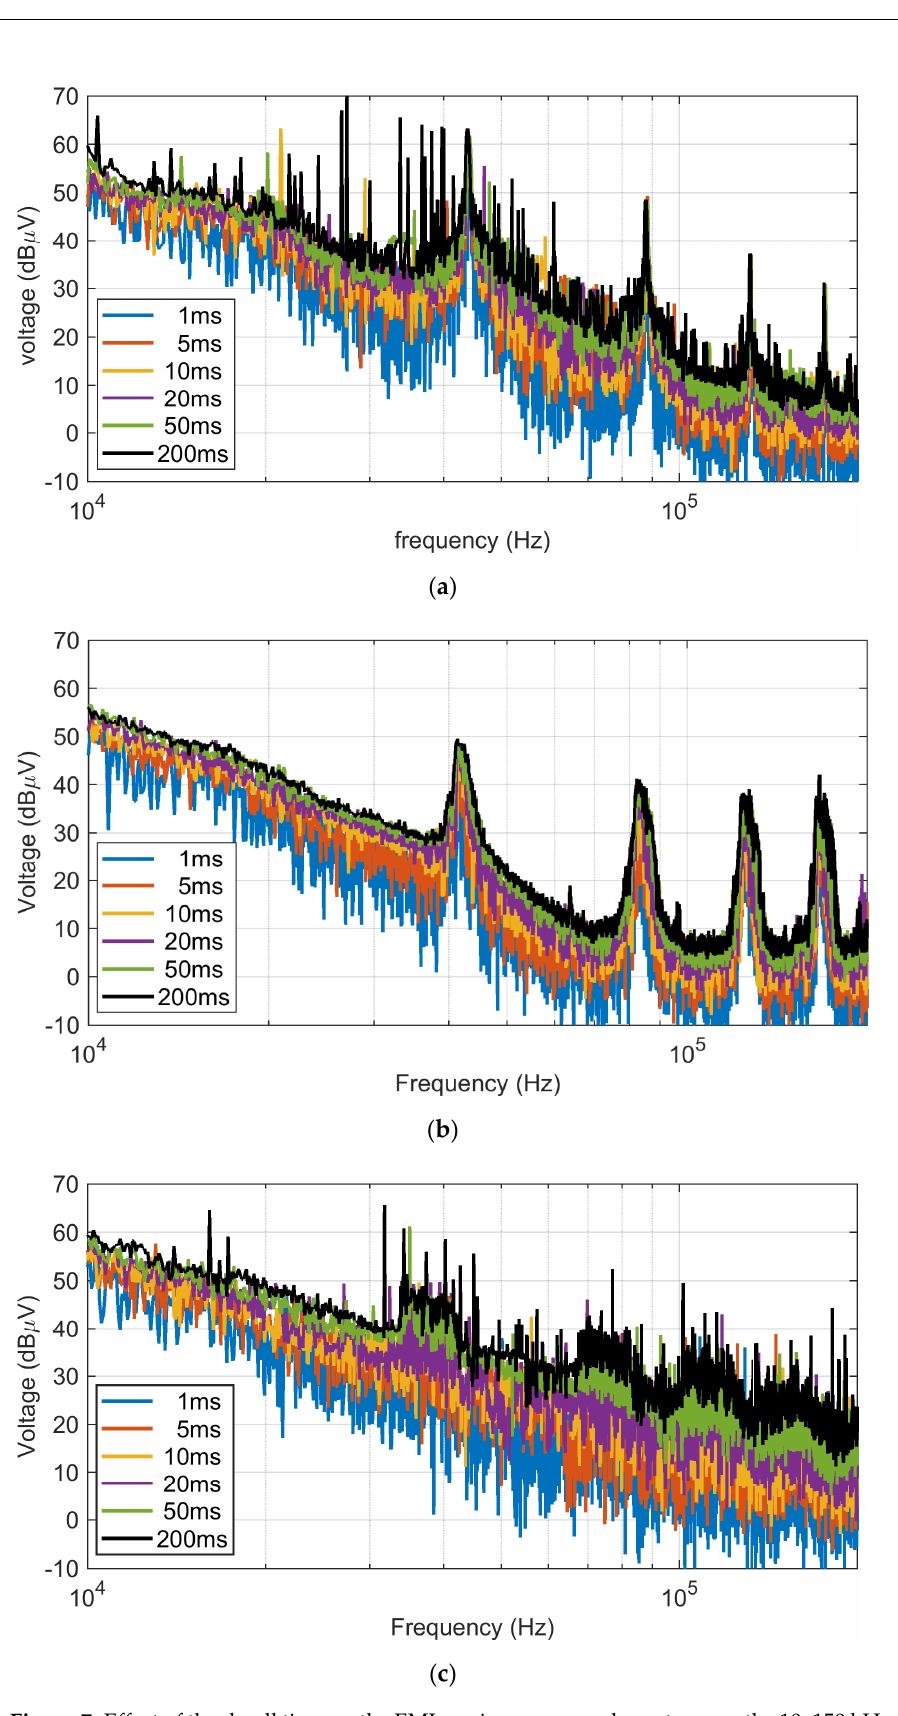
Figure 7. Effect of the dwell time on the EMI receiver measured spectra over the 10–150 kHz frequency interval for ( a ) LB-P90, ( b ) KT-P90 and ( c ) SH-P90.